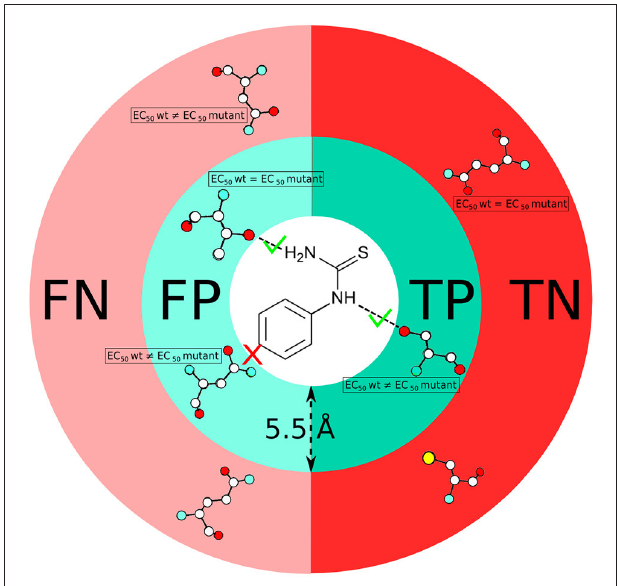
FIGURE 2 | Scheme showing the definition of true positive (TP), false positive (FP), true negative (TN) and false negative (FN) residues used in this study. Comparison of predicted residues with experimental data (EC 50 values) is performed on the basis of both a distance cut-off (5.5 Å) and a chemical definition (i.e., presence or absence of a canonical protein/ligand